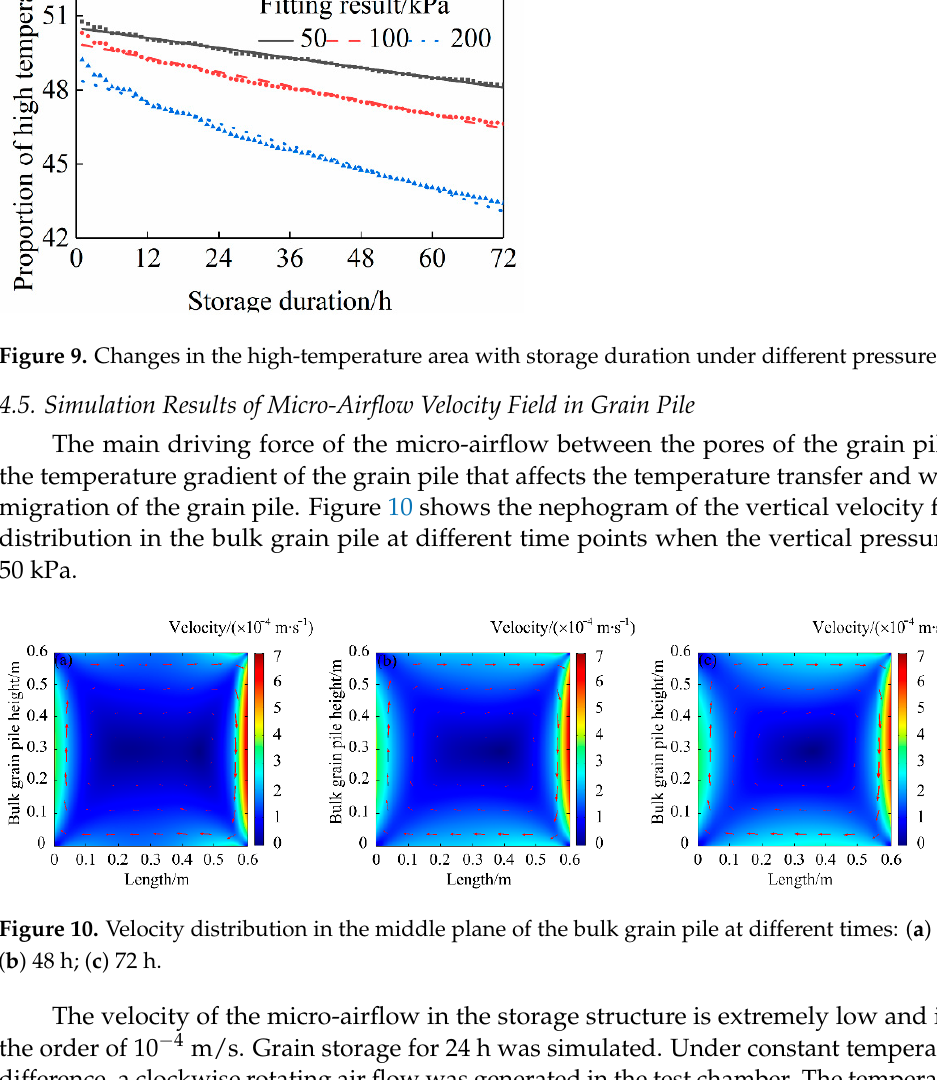
Figure 9. Changes in the high-temperature area with storage duration under different pressures.